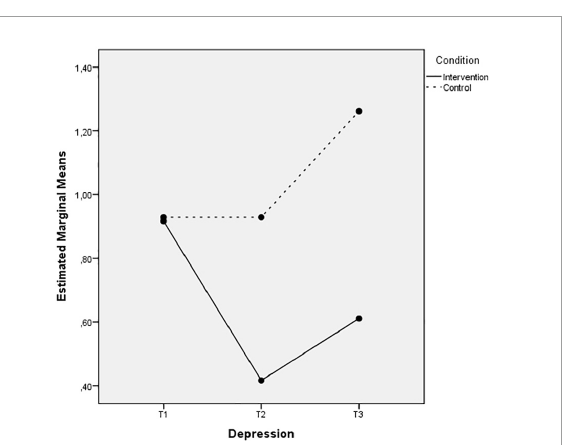
FIGURE5 Mean of perceived helplessness against stress showing time effects for control and intervention groups.